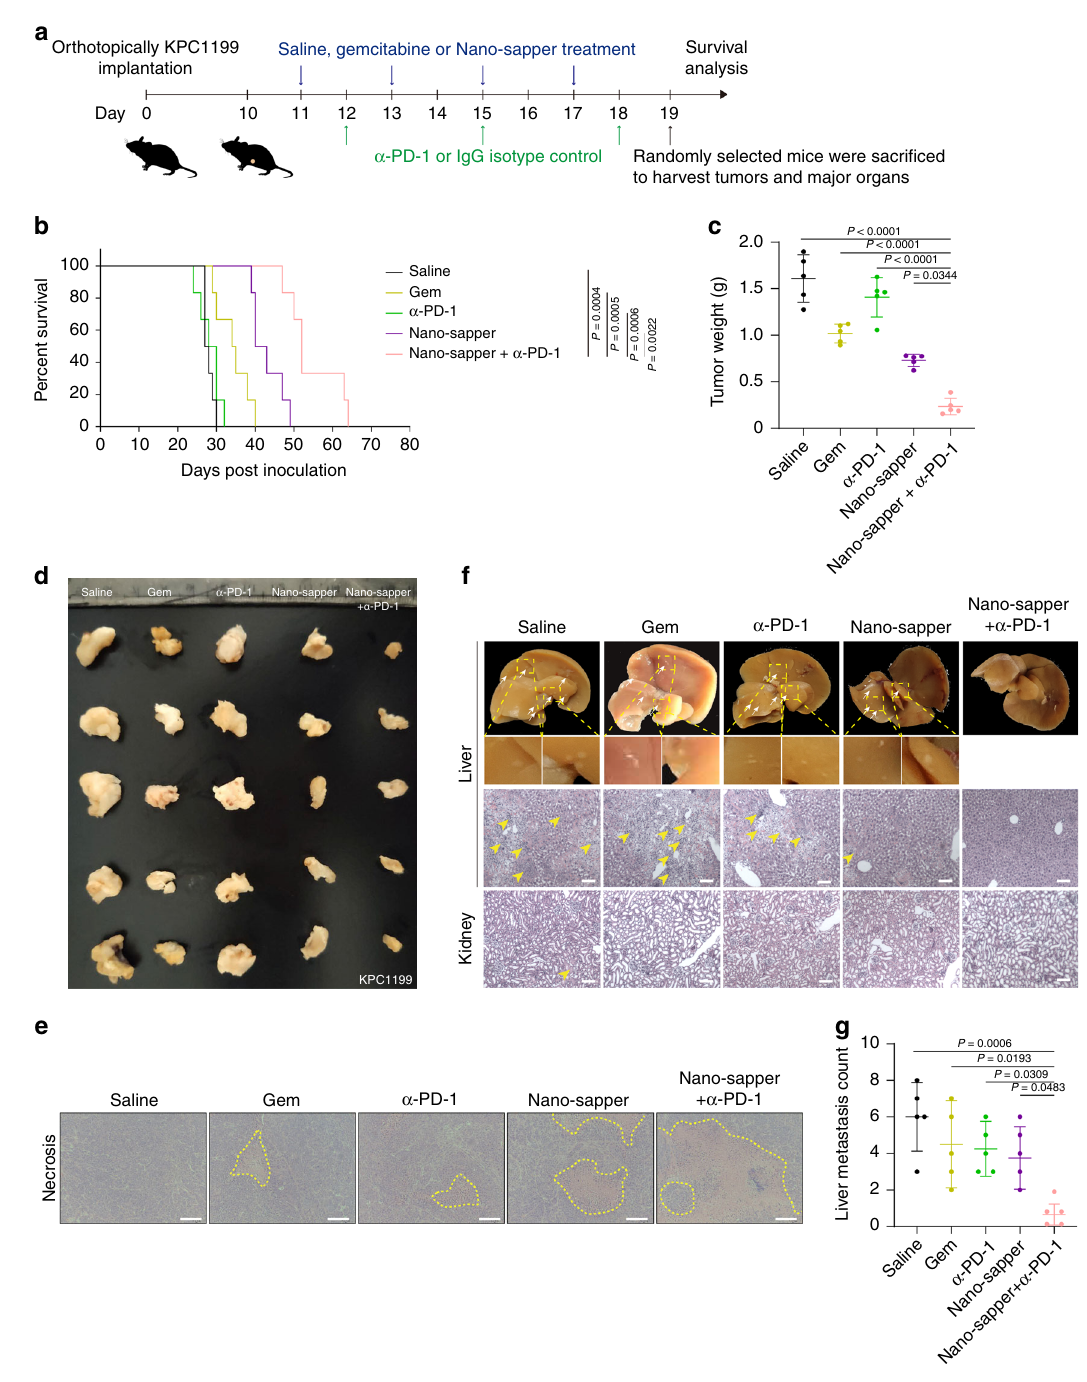
Fig. 7 Nano-sapper synergized with α -PD-1 to suppress tumor growth and metastasis in KPC1199 PDAC model. a Six-week-old male C57BL/6 mice were orthotopically inoculated with KPC1199 cells (1 × 10 6 ) on day 0. Saline, Gem (15 mg/kg) and Nano-sapper (MP = 13.9 mg/kg, 25 μ g plasmid per mouse) were i.v. administered every other day and α -PD-1 or IgG isotype (200 μ g per mouse) were i.p. administered every 2 days ( n = 12 mice). One day after the fi nal α -PD-1 treatment, fi ve mice were randomly sacri fi ced to extract tumors and major organs, while the rest mice were continually subjected to survival analysis. b Mice survival curves in each treatment group ( n = 6 mice). c , d Tumor inhibition of different treatments ( n = 5 mice). e H&E staining histology of tumor necrosis. Scale bars, 100 μ m. f , g H&E staining histology of tumor metastasis in liver and kidney. Nodules of metastasis were indicated by white arrows and focal necrosis were indicated by yellow arrows ( n = 5 mice). Data are presented as mean ± s.d. One-way ANOVA with Bonferroni multiple comparisons post-test was used for ( c ) and ( g ). Kaplan – Meier analysis with log-rank Mantel-Cox test (two-sided) was used for ( b ). Error bars represent